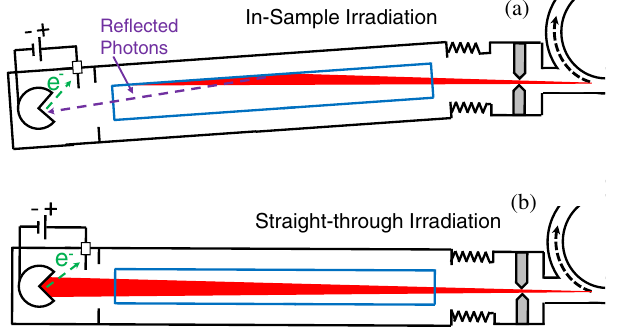
FIG. 6. Schematic description of the operation principle of the reflectivity studies at the BESTEX. Photoelectrons originating at the photon cup (green arrow) are collected by the electrode ’ s positive bias and measured. (a) In-sample irradiation geometry. The photon cup is irradiated by photons reflected on the sample (purple arrow). (b) Straight-through irradiation geometry. The photon cup is irradiated by direct SR from KARA ’ s bending